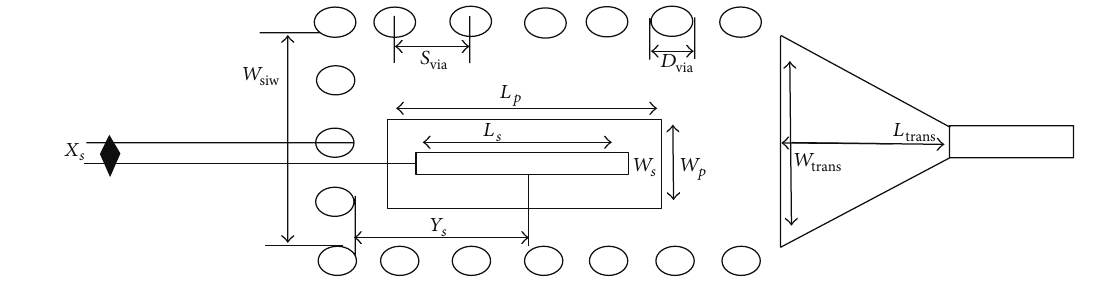
Figure 2: 2D top view, SIW parameters.